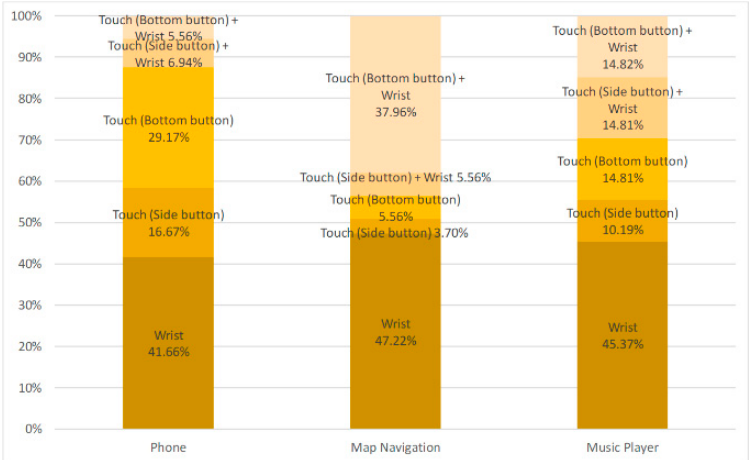
Figure 6. Observed percentages of wrist gestures for in-vehicle interactions. Bottom button was highly preferred for both simple and complex gestures. Simple wrist gestures were performed for interacting with a music player and simple touch gesture were performed for phone activities (they show a clear influence of prior experience).